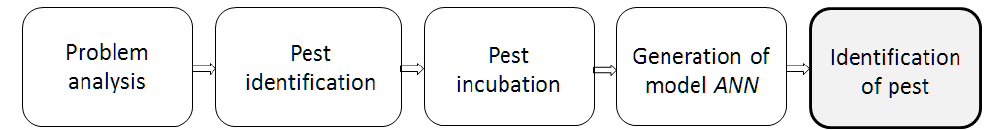
Figure 3. Scheme of procedure. ANN: artificial neural network.